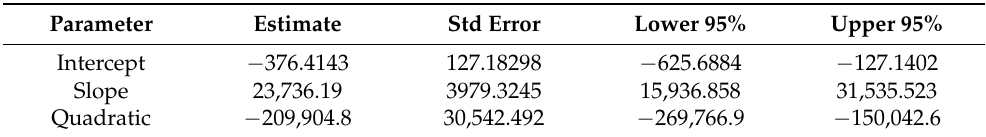
A plotted representation of the quadratic model in the range of the feed rates used is shown in Figure 19. Table 9. Basic parameters of the quadratic model of the dependence of the number of drilled holes up to the moment of tool damage on the feed rate.